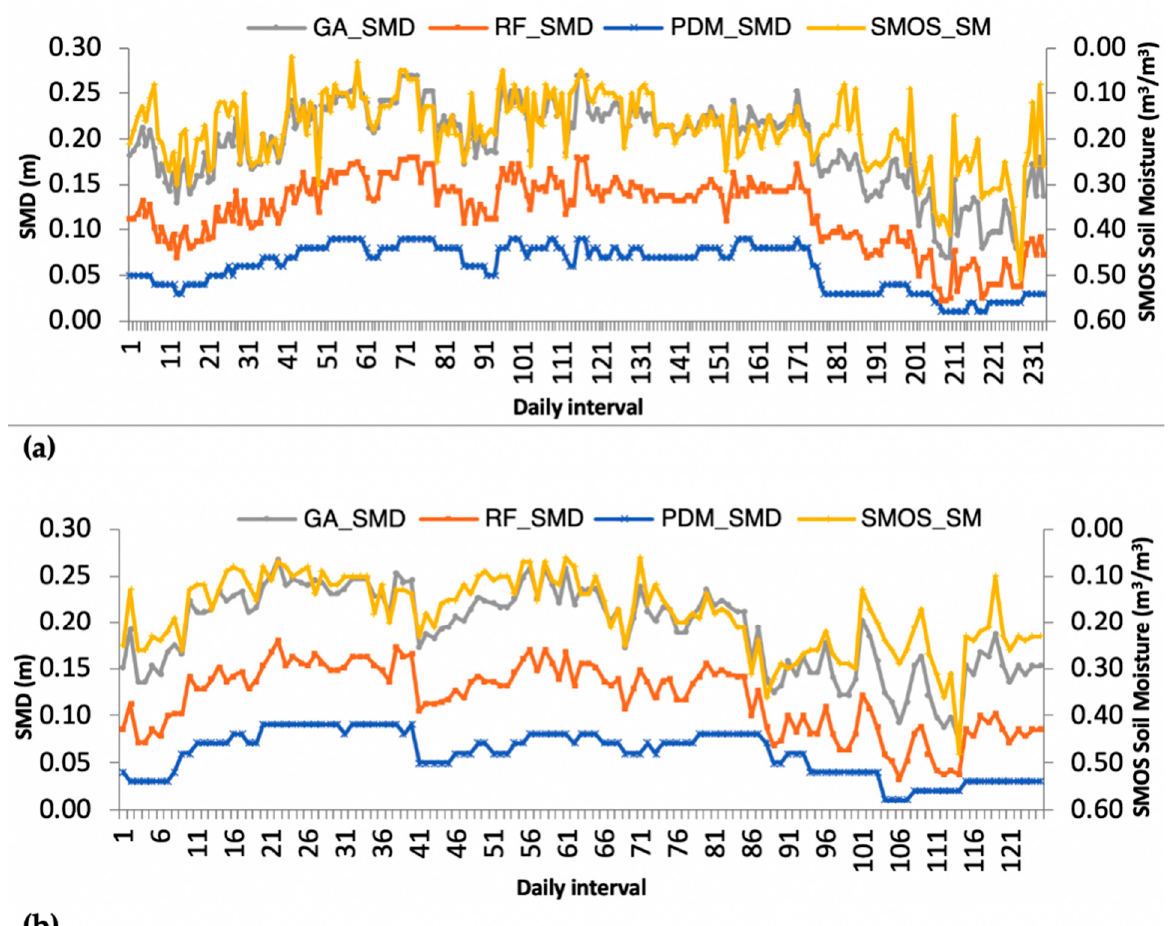
Figure 2. Temporal trend in SMOS soil moisture and SMD from different approaches ( a ) calibration and ( b ) validation.